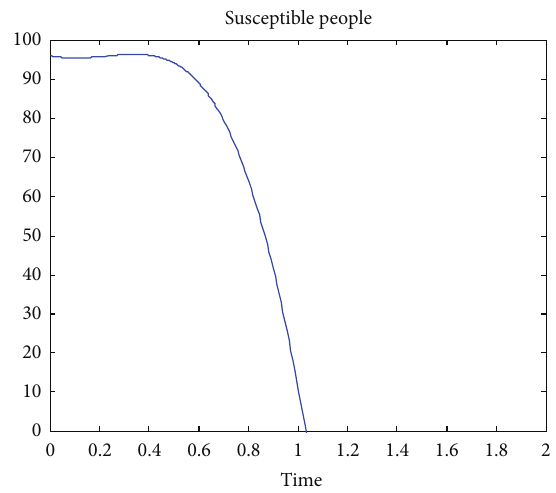
Figure 1: Approximate solution for the number of susceptible people in the location.